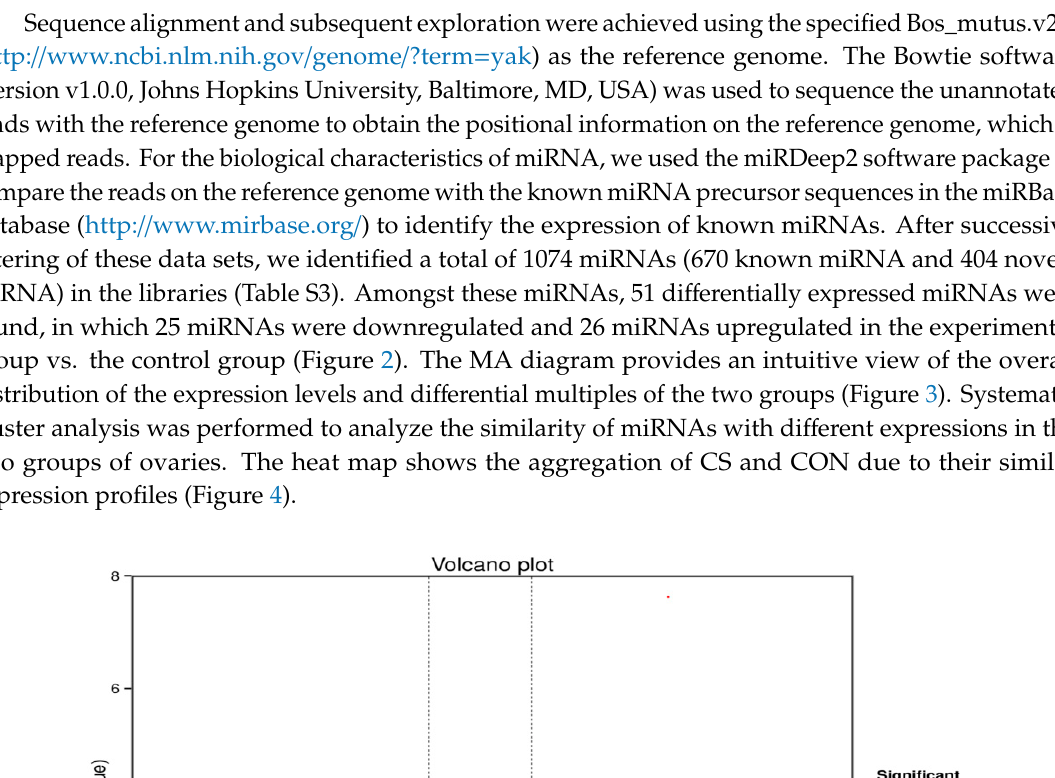
Figure 3. MA diagram of differentially expressed miRNA in the CS and CON groups.